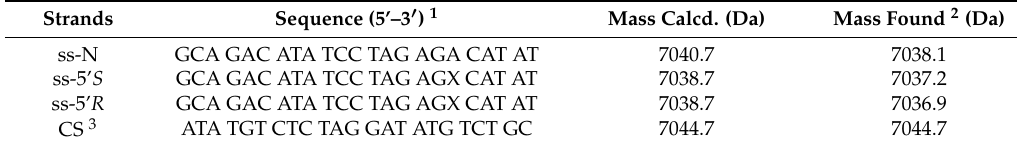
Table 2. Sequences and molecular masses of the synthesized